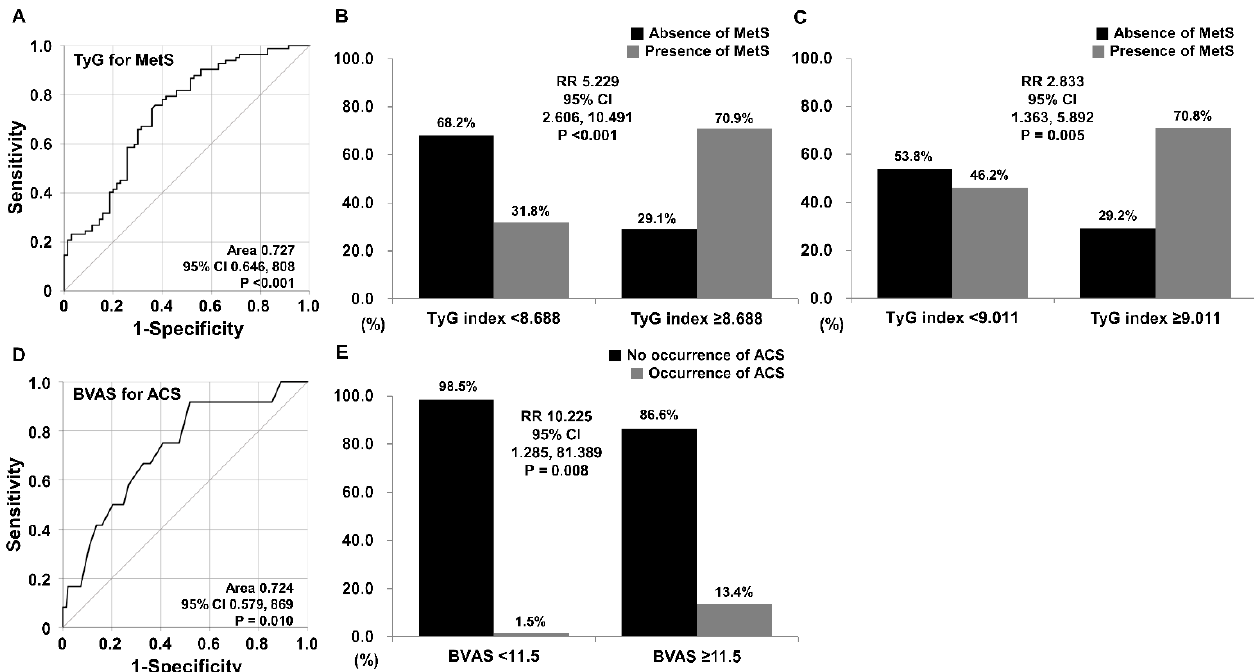
Figure 2. TyG index estimating MetS and BVAS anticipating ACS. ( A ) The cut-off value of the TyG index for the presence of MetS was obtained using the ROC curve and was set as 8.688. ( B ) AAV patients with a TyG index ≥ 8.688 more often had MetS than those with a TyG index < 8.688. ( C ) When the cut-off TyG index of 9.011 was applied, AAV patients with a TyG index ≥ 9.011 more frequently had MetS than those with a TyG index < 9.011. ( D ) The cut-off of BVAS for ACS occurrence was obtained using the ROC curve and was set as 11.5. ( E ) AAV patients with BVAS ≥ 11.5, exhibited a significantly higher risk for the occurrence of ACS than those with BVAS < 11.5. TyG, triglyceride-glucose; MetS, metabolic syndrome; ROC, receiver operating characteristic; AAV, ANCA-associated vasculitis; ANCA, antineutrophil cytoplasmic antibody; BVAS, Birmingham vasculitis activity score; ACS, acute coronary syndrome.